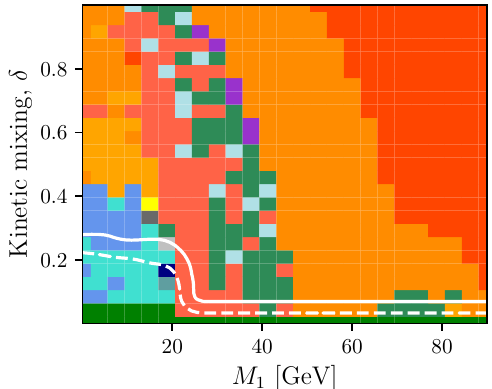
Figure 14 . The 95% CL (solid) and the 68% CL (dashed line) exclusions on the kinetic mixing δ versus the M 1 parameter. Here m D = 2 m Z 0 and so the limits correspond to the case of light Z 0 decaying to SM fermions only. The scan on δ is done in the range 10 − 5 to 1 and the colored bins correspond to the analyses pool giving the dominant contribution.